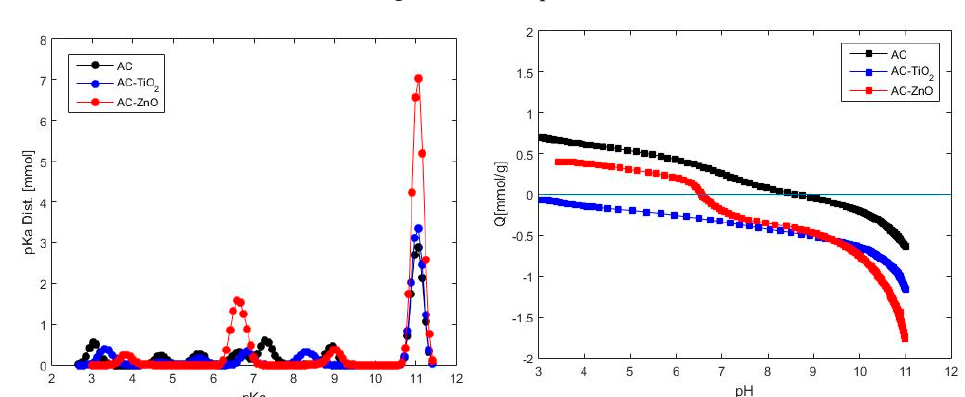
Figure 5. From left to right, pKa distribution and proton binding curves.